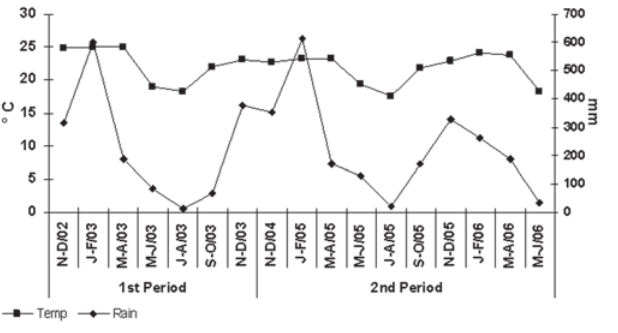
Fig. 2. Bimonthly variation of average air temperature (°C) and total rainfall (mm) at Lobo Reservoir during the first and second period of study.